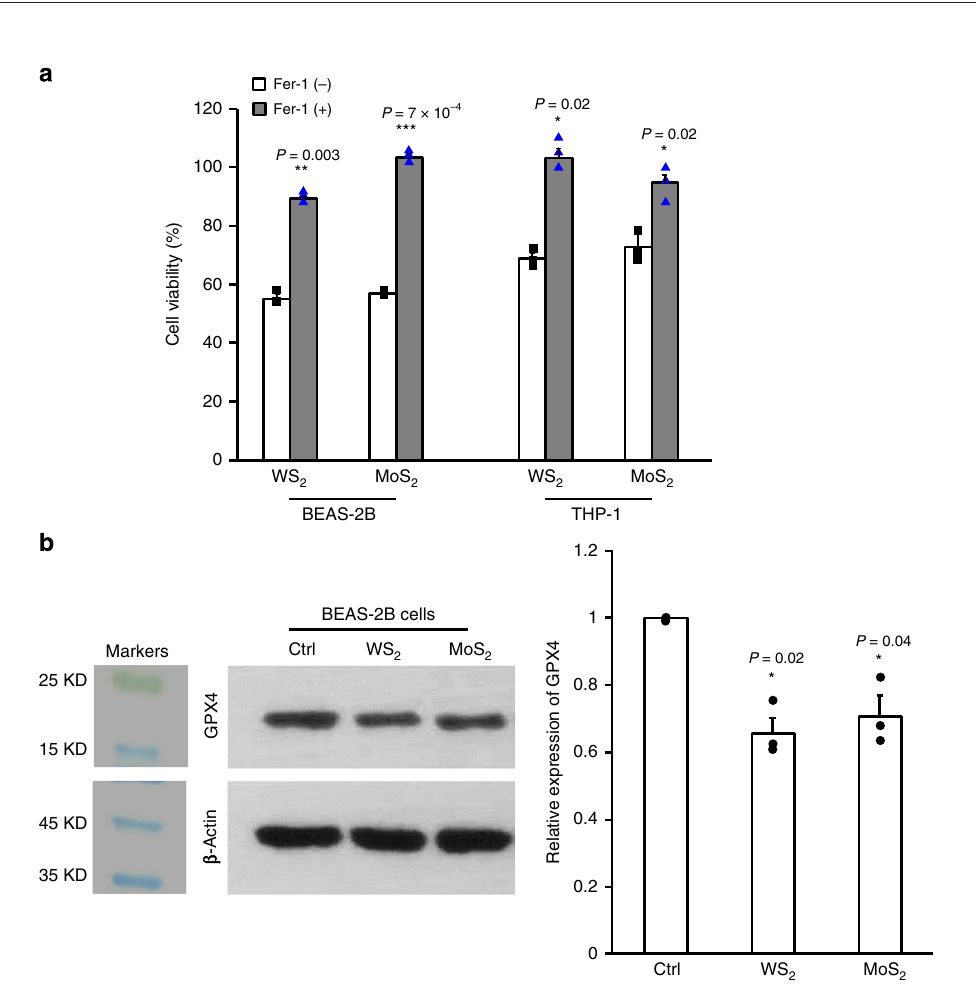
Fig. 3 Biomarkers of ferroptosis in TMD-exposed cells. a Representative images of Fe 2 + in cells by confocal microscope. BEAS-2B cells treated by 100 μ M Fe(NH 4 ) 2 (SO 4 ) 2 , 200 μ g/mL WS 2 and MoS 2 were stained by FeRhoNox (red) to visualize the cellular distribution of Fe 2 + . Hoechst 33342 and WGA were used to stain nuclei (blue) and cell membrane (green), respectively (scale bar: 10 μ m). Shown are the representative images from three independent cell samples. b Effects of Fe 2 + chelators on WS 2 and MoS 2 induced cytotoxicity ( n = 3 biologically independent cell samples). BEAS-2B cells pretreated by 2 mM DFP or 0.4 mM DFX were exposed to 200 μ g/mL WS 2 and MoS 2 and examine cell viability after 48 h incubation. Data are presented as mean values ± SD. *** p < 0.001 compared to untreated cells by two-tailored Student t -test. c Comparison of cell viabilities in wide-type and TfR-KD cells, cell viabilities in wide-type and TfR-KD cells exposed to 200 μ g/mL WS 2 /MoS 2 for 48 h were assessed by ATP assay ( n = 3 biologically independent cell samples). Data are presented as mean values ± SD. ** p < 0.01, *** p < 0.001 compared to wide-type cells by two-tailored Student t -test. d Representative images of ROS and e lipid peroxidation in BEAS-2B cells. After 12 incubation with 200 μ g/mL WS 2 and MoS 2 for 12 h, BEAS-2B cells were stained with H 2 DCF-DA (scale bar: 10 μ m) and Image-iT lipid peroxidation staining kit (scale bar: 10 μ m) for confocal observation of nuclei (blue), reduced substrate (red), and oxidized substrate (green). 10 μ M CH were used as positive controls. Shown are the representative images from three independent cell samples.